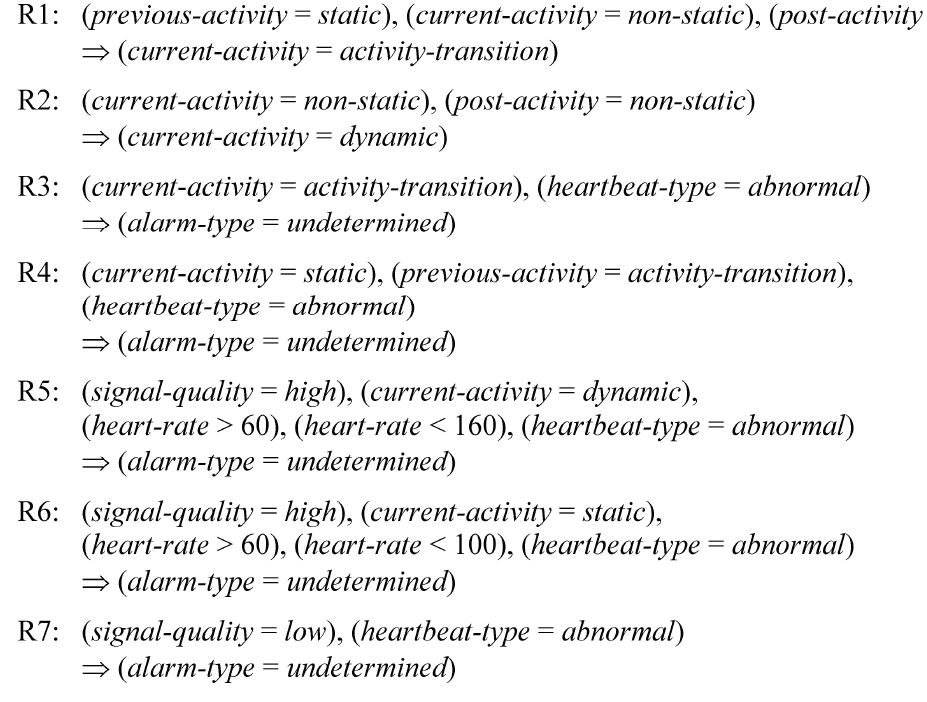
Figure 9. ECG signals ( Above ) and 3D acceleration signals ( Below ) when a subject was jogging.